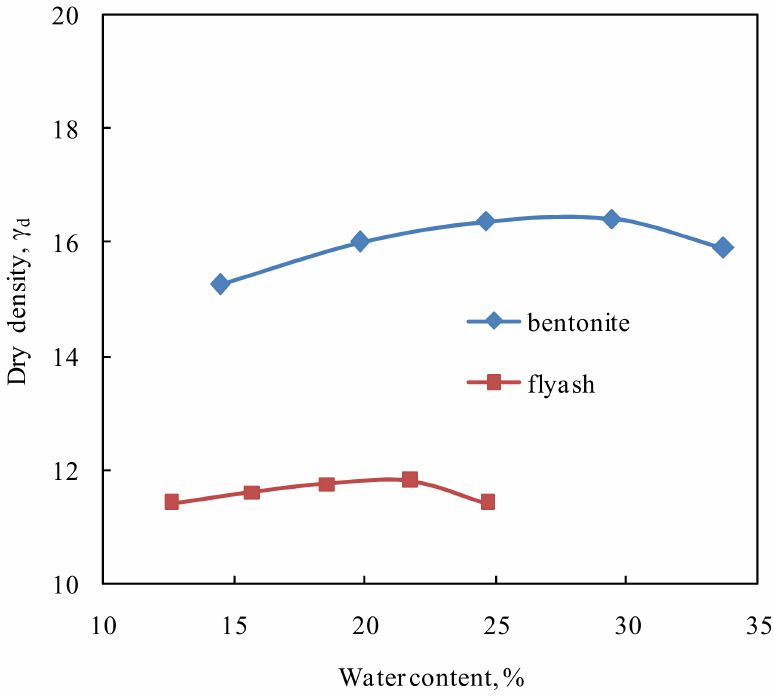
Figure 5. Proctor compaction curve of fly ash and